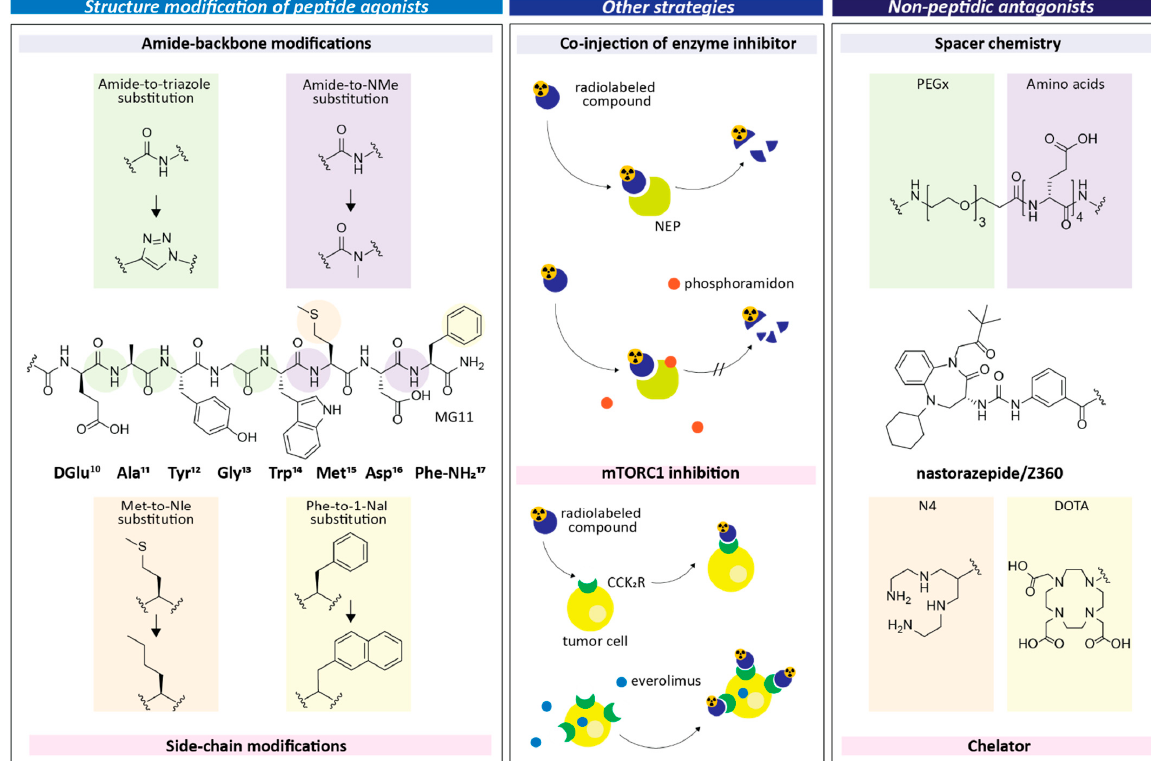
Figure 1. Recent developments aiming towards optimizing CCK2R targeting (as described in references: [21–36]).